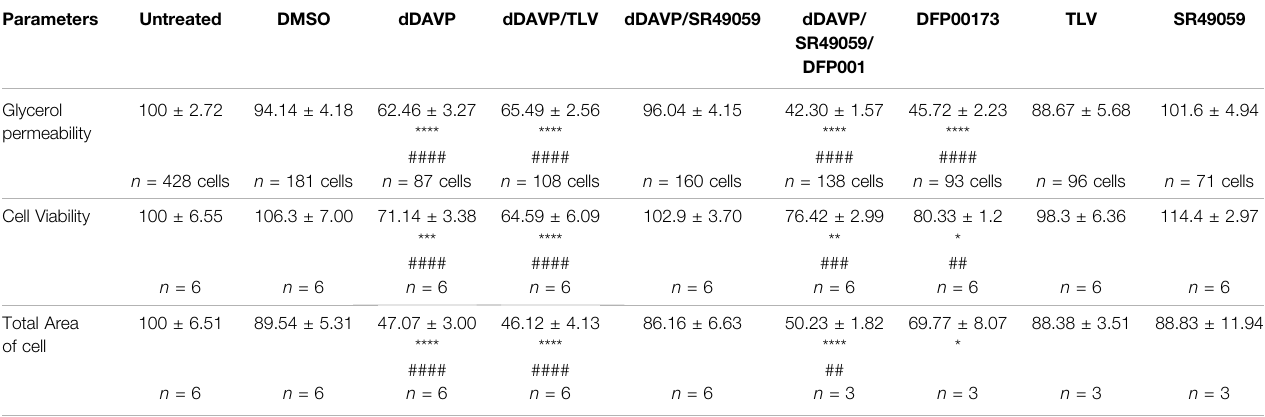
TABLE 1 | Glycerol permeability, cell viability and total area of cell. Values represent the mean ± S.E.M. and analyzed by one-way ANOVA followed by Dunnett ’ s Multiple Comparison test. *Signi fi cantly different versus Untreated (**** p < 0.0001, ** p < 0.01, * p < 0.05). # Signi fi cantly different versus DMSO ( #### p < 0.0001, ### p < 0.001, ## p <